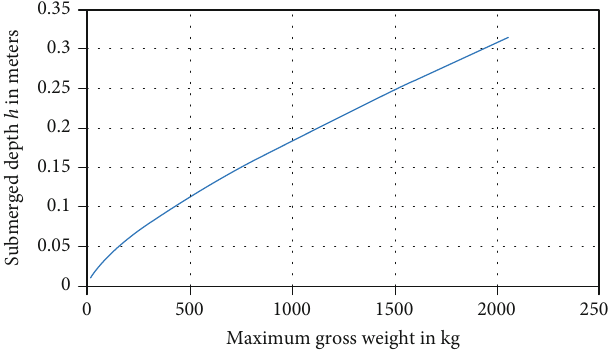
Figure 20: Plot of the submerged depth against gross weight of the FPV module in Ex.1.